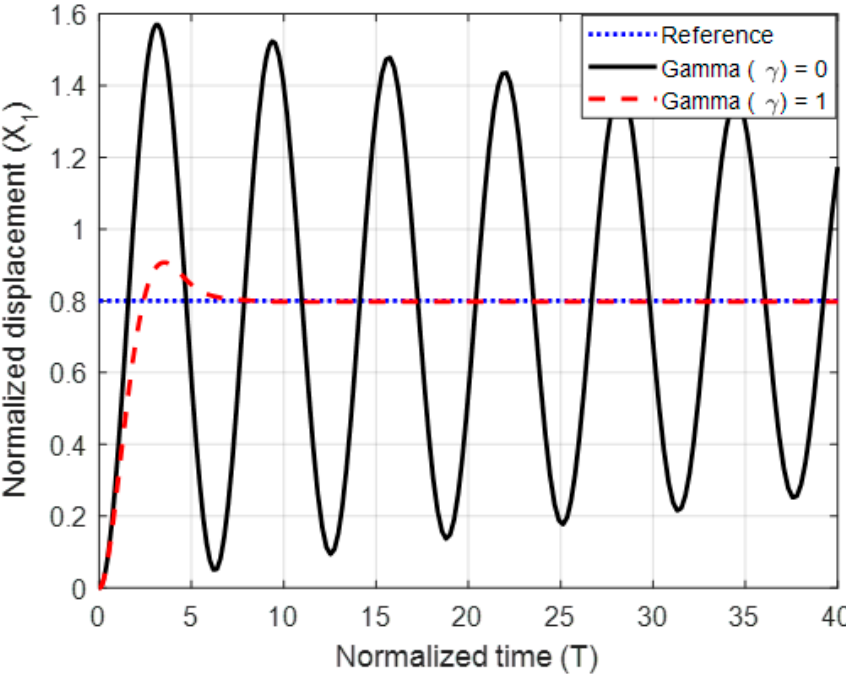
Figure 10. The normalized displacement with and without the coupling constant at a gap distance of 0.8 and damping ratio ζ = 0.01.